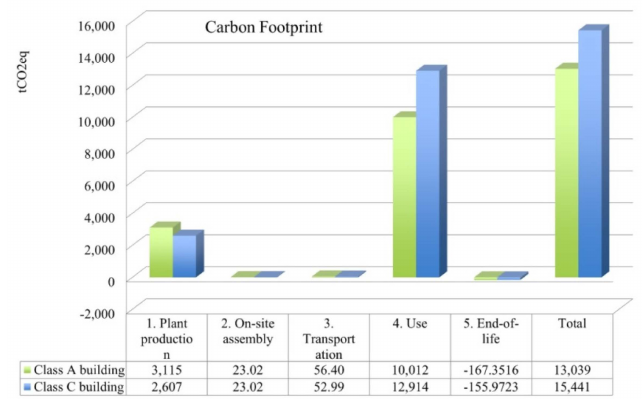
Figure 9. CF of a 10,000 m 2 building under the reference scenario ( green ); Results for an energy class C building with standard insulation is also shown ( blue ).